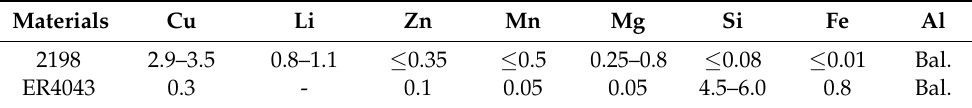
Table 2. Composition of the base materials and wire (wt %).